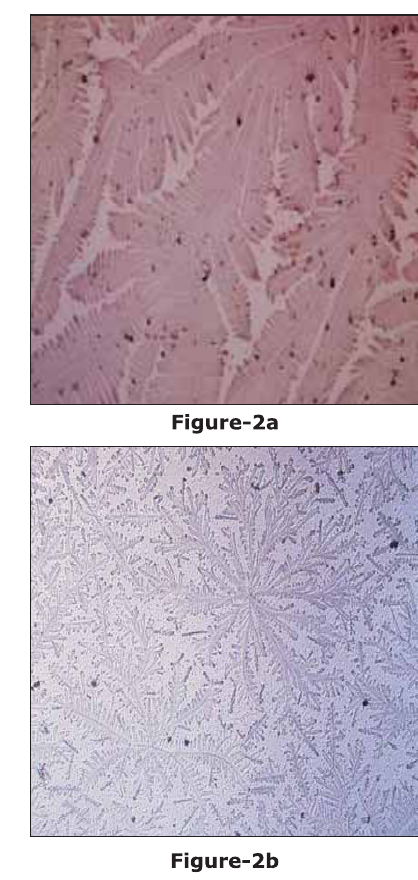
Figure-2: Typical (a) and atypical (b) arborisation pattern of cervical mucus in 94 Murrah buffaloes during